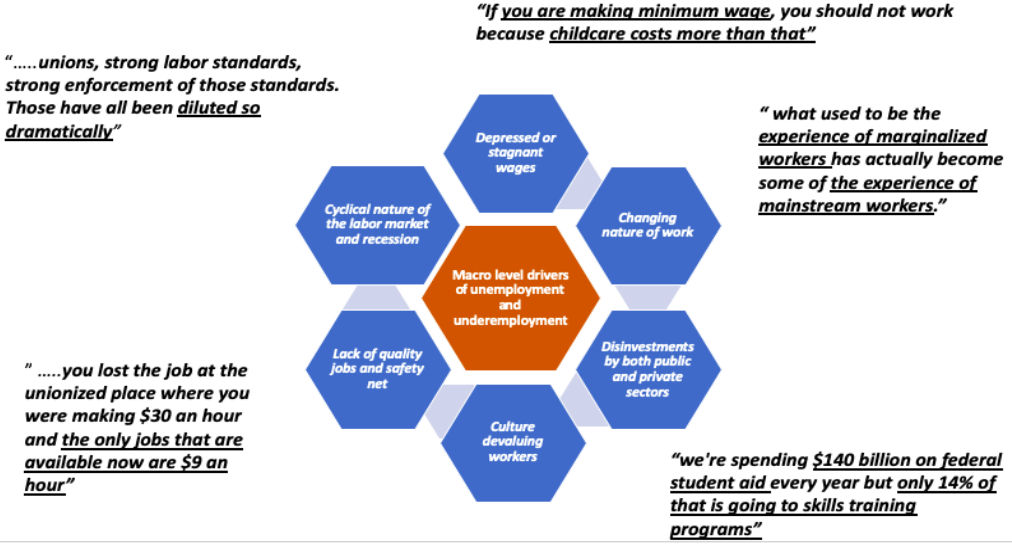
Figure 1. Description of the key themes emerging from the literature review and key informant interviews.